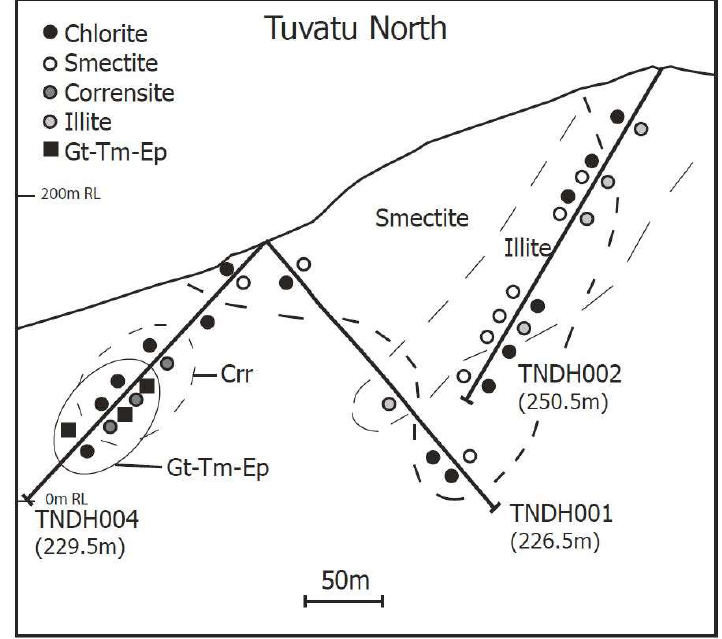
Figure 10. Cross-section through the Tuvatu North prospect showing drill holes TNDH001, TNDH002, and TNDH004 and the down-hole distribution of alteration minerals: smectite, illite, corrensite (Crr), garnet (Gt), tremolite (Tm), and epidote (Ep). The length of the drill holes is also indicated.